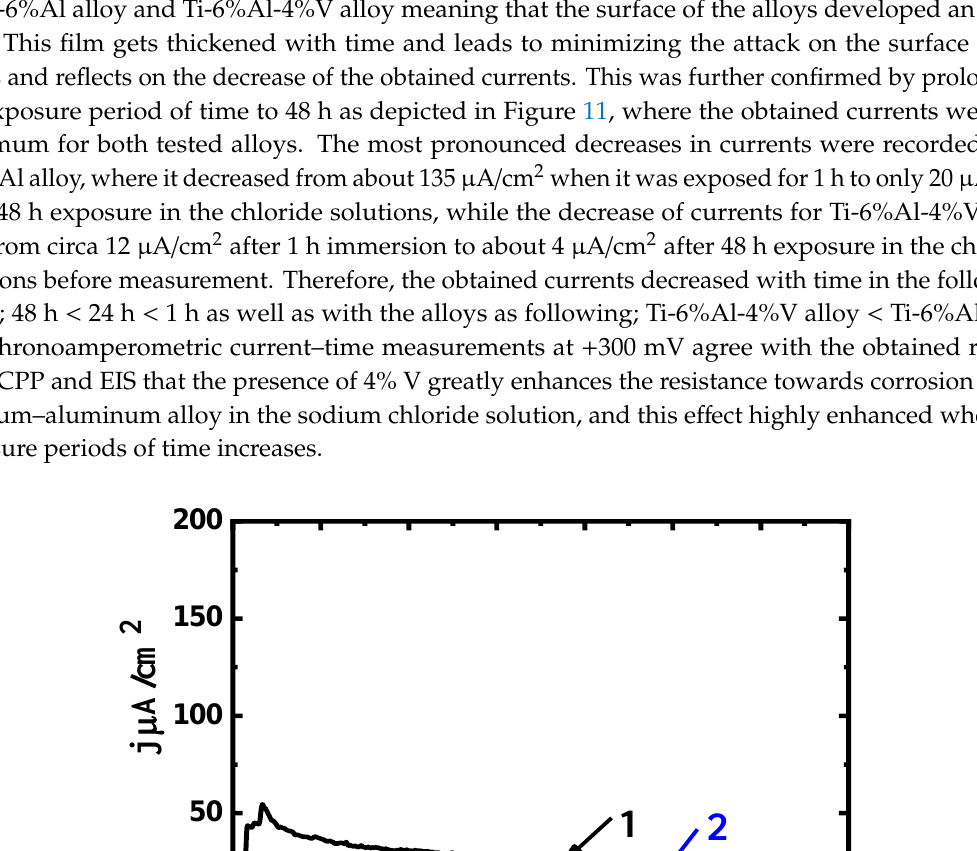
1 Figure 11. Change of current with time at 300 mV for (1) Ti-6%Al and (2) Ti-6%Al-4%V alloys after immersion in 3.5% NaCl solution for 48 h.